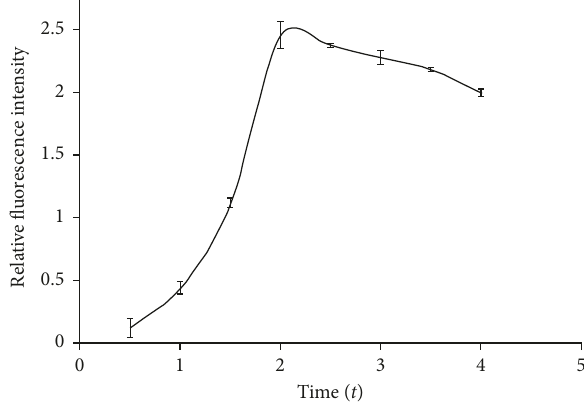
Figure 5: Optimized curve of MOR hapten concentration.